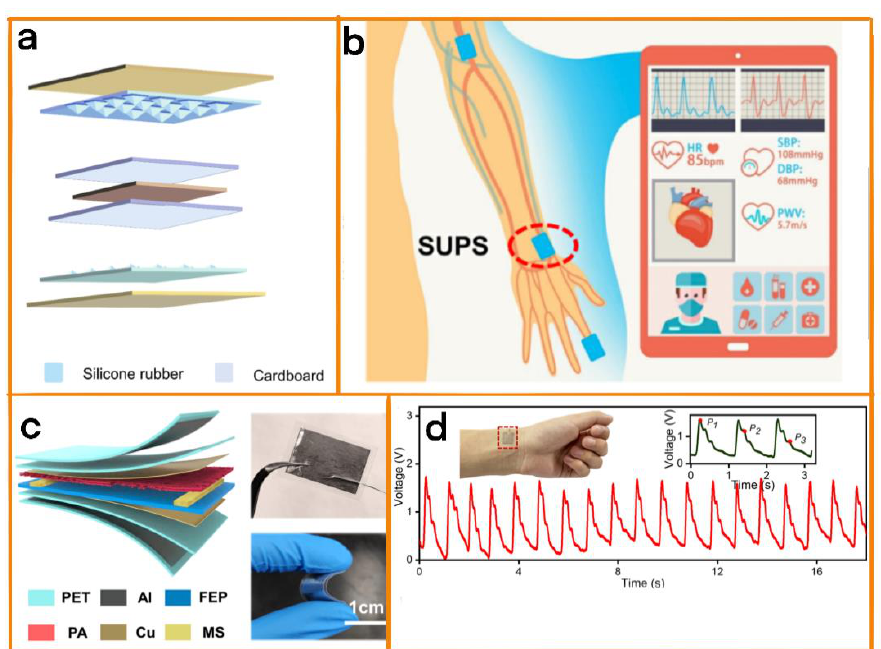
Figure 5. ( a ) Triboelectric nanogenerator sensor with a double sandwich structure. Reprinted with permission from [54]. 2022, Nano Research. ( b ) Integrated description of SUPS for non-invasive multi-index pulse monitoring. ( c ) Schematic diagram of the structure of SUPS. Optical photo of the built SUPS. Reprinted with permission from [55]. 2021, Elsevier. ( d ) FPS test radial pulse wave. Reprinted with permission from [56]. 2022, Elsevier.